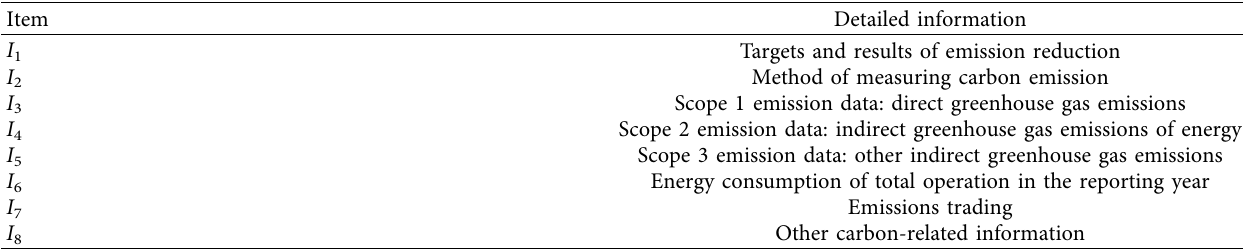
Table 2: Eight items of CID.